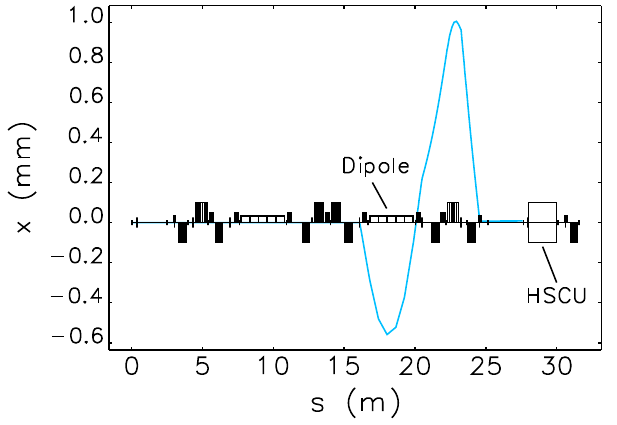
FIG. 34. Orbit bump that generates positive orbit angle at the exit of the dipole, which only spans half the sector and has small overall orbit distortion. One lattice sector is shown. The 1-mrad dipole is located at 24.5 m point, where the orbit bump ends.